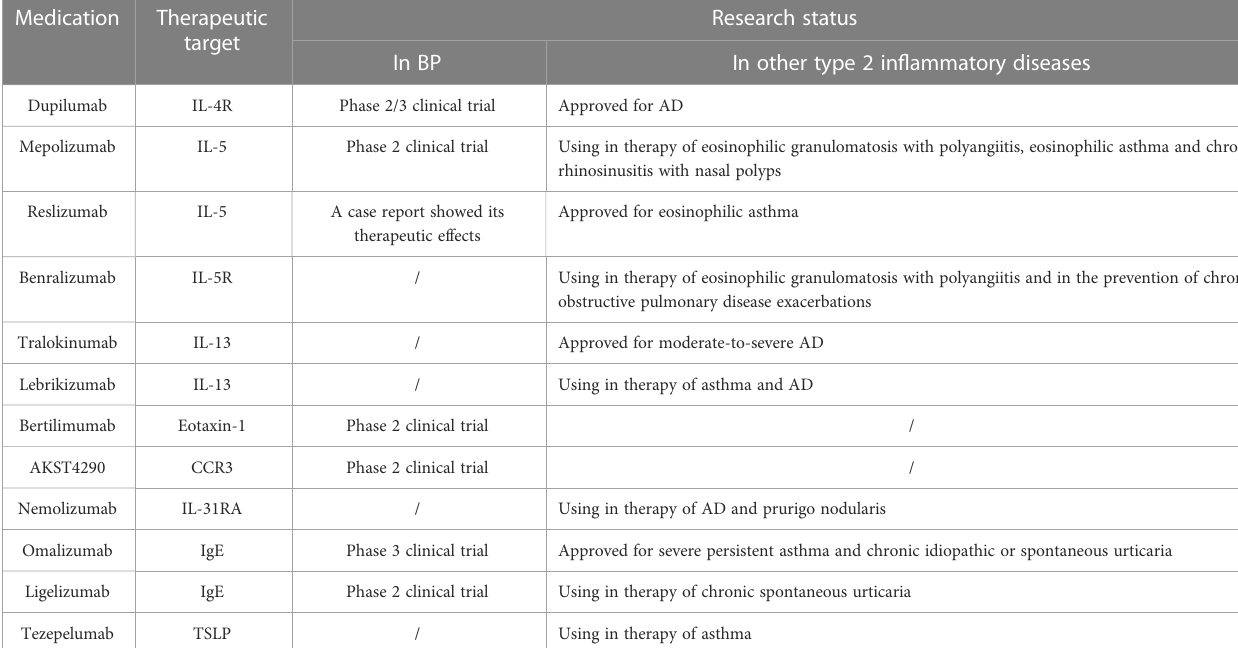
TABLE 1 Therapeutic targets and medication related to type 2 in fl ammation in BP.